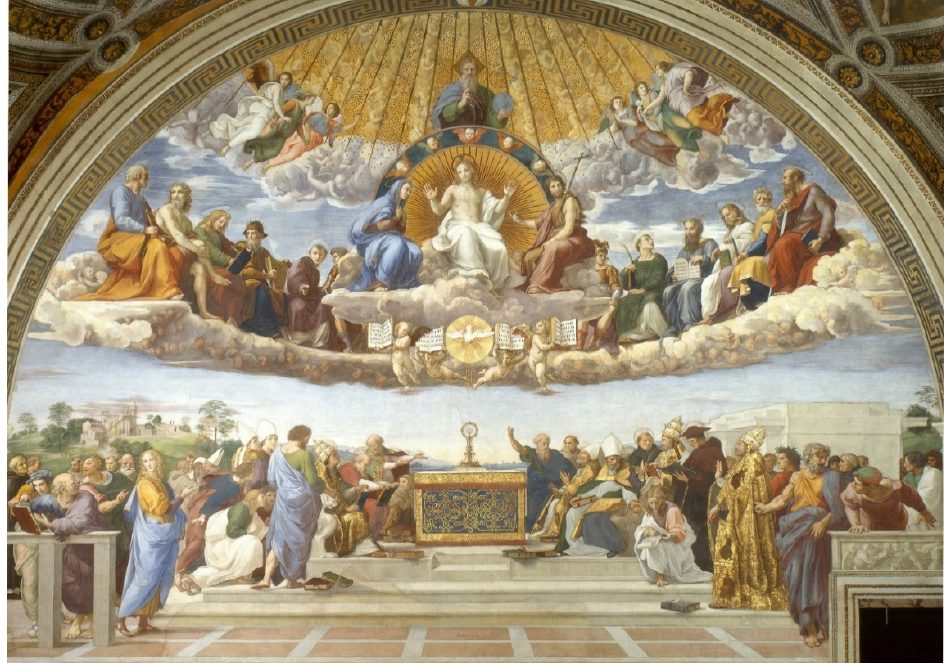
Figure 8. Raffaello, The Disputa, 1509, Vatican Palaces, Rome.